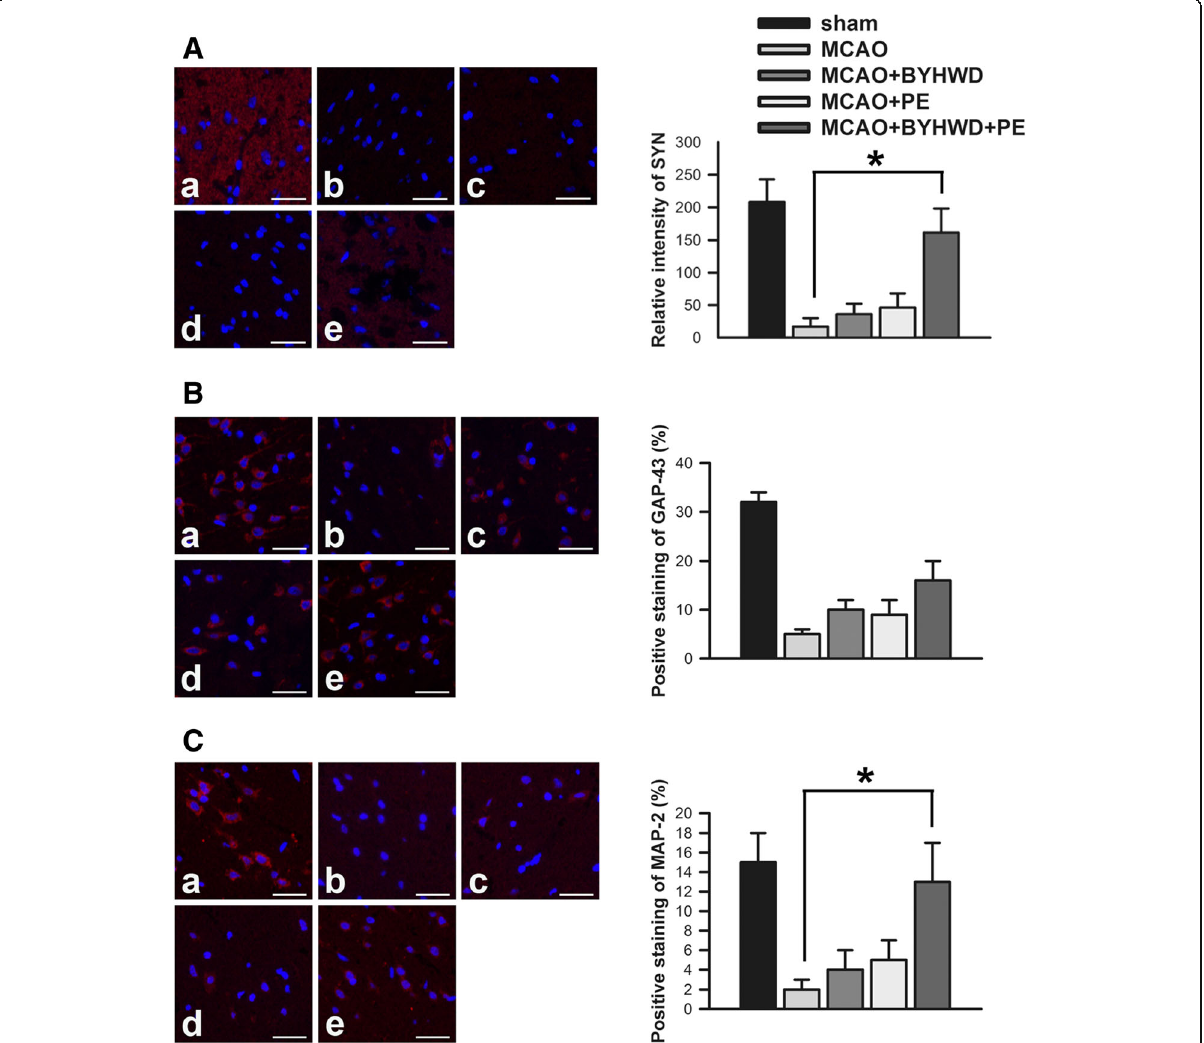
Fig. 4 High magnification micrographs of the immunohistochemical fluorescent labeling of SYN (SYN-1), GAP-43 and MAP-2. The immunohistochemistry micrographs display the locations of the SYN ( a ), GAP-43 ( b ) and MAP-2 ( c ) proteins in sham ( a ), MCAO ( b ), MCAO + BYHWD ( c ), MCAO + PE ( d ) and MCAO + BYHWD + PE ( e ) groups. The scale bars =20 μ m. The bars indicate the means ± the standard errors of the means; *, p < 0.05, relative to the MCAO